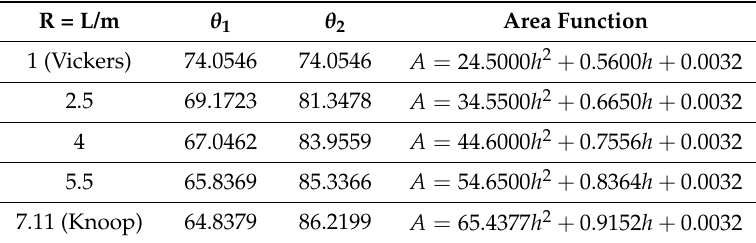
Table 1. Area function of the indenters used in the numerical simulations.